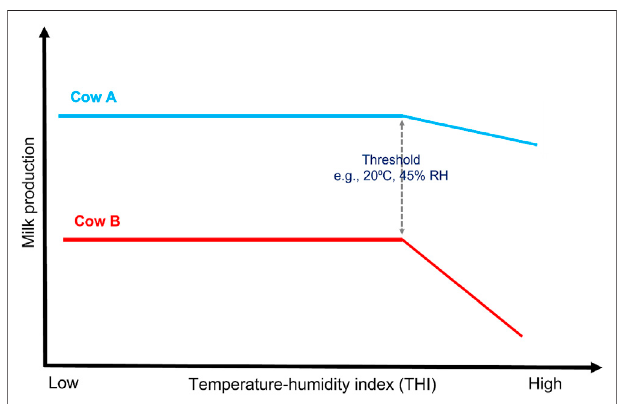
FIGURE 3 | Illustrative description of heat tolerance. Cow A and Cow B produceacomparable quantity ofmilk atthermoneutralconditions(i.e.,atlow THI).AstheTHIincrease,themilkyieldat fi rstremainsunaffecteduptoagiven point called a threshold at which the yield begins to decline for both cows,buttherateofdecline(slopes)ismoreforCowBthanCowAwhichisG ×E.Therefore,CowAisconsideredmoretoleranttoheatthanCowB,andthe slope trait can be for milk, fat, and protein yield.